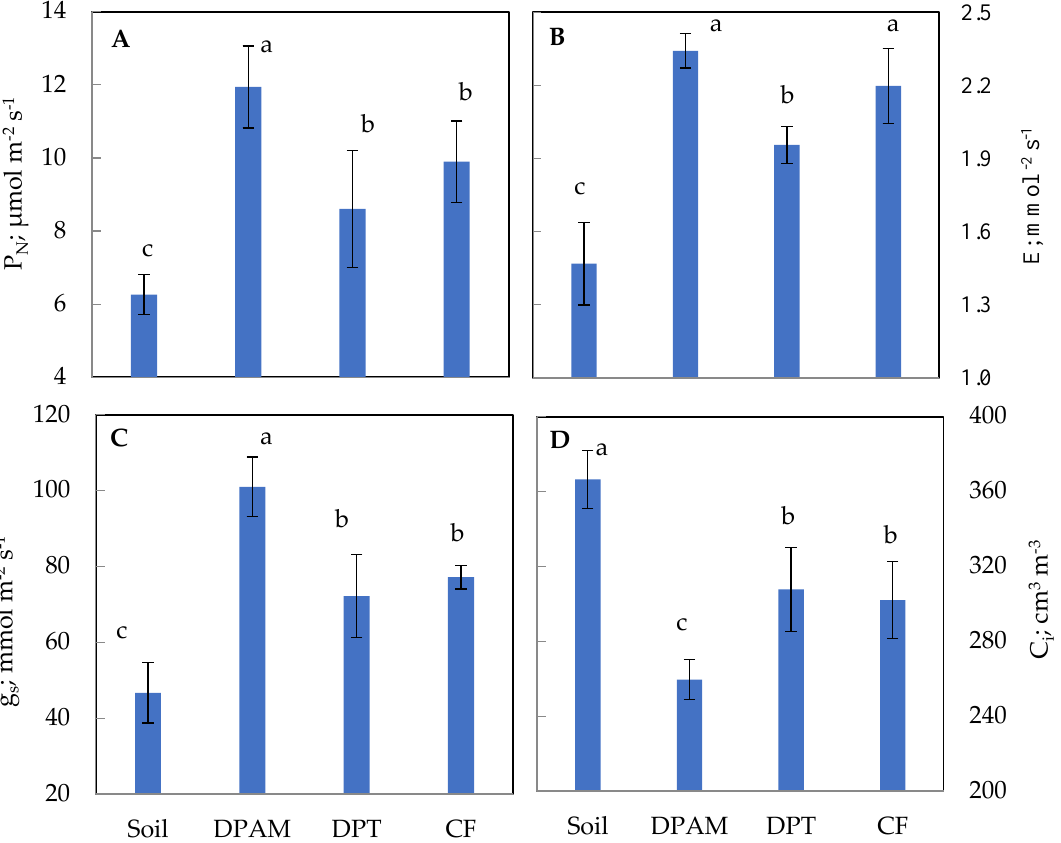
Figure 3. Effects of the culture substrates on photosynthesis parameters in leaves of tomato plants. DPAM: compost of date-palm residues and animal manure; DPT: compost of date-palm trunk; CF: coconut fiber, compared with soil substrate. ( A ): Photosynthetic assimilation rate (P N : µmol CO 2 m - 2 s -1 ); ( B ): transpiration rate (E: mmol (H 2 O) m -2 s -1 ); ( C ): stomatal conductance (gs: mmol (H 2 O) m -2 s -1 ); ( D ): intercellular CO 2 concentration (Ci: µmol (CO 2 ) mol -1 ). The plants were 5 months old. The results represent the mean of nine replicates ± S.D. Vertical bars indicate standard errors of means. Numbers followed by a different letter within a panel are significantly different at p ≤ 0.05 , according to the least significant difference (LSD) analysis.